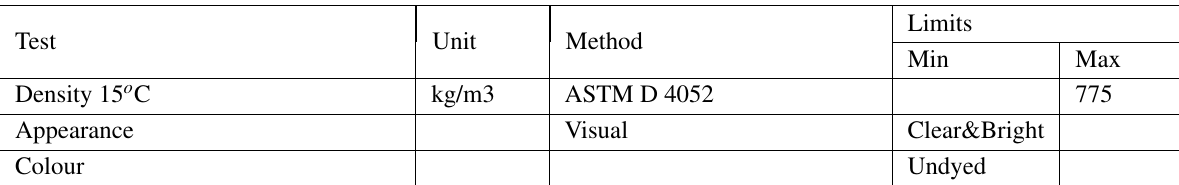
Table 1. shows gasoline (RON 95) specification: EUROGRADE GASOLINE (RON